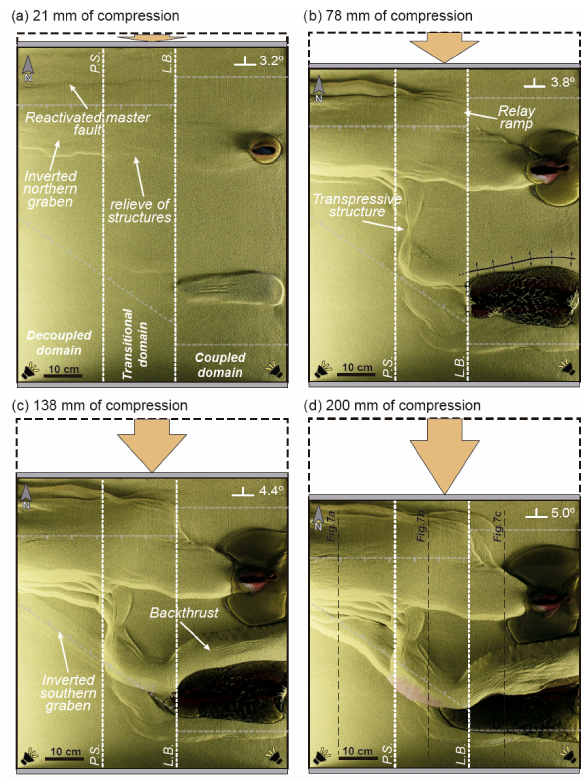
Figure 6. Overhead pictures showing the evolution of model 2. Il- lumination comes from the left. The position of the basement rigid blocks is shown in grey dotted lines, and the pinch-out of the poly- mer (P.S.) and the limit of basement blocks (L.B.) are shown in white dotted lines. (a) Overhead view after 21mm of shortening. (b) Overhead view after 78mm of shortening. (c) Overhead view after 138mm of shortening. (d) Overhead view at the end of the ex- periment (200mm shortening). No syn-tectonic sedimentation was performed during the compressional phase of this